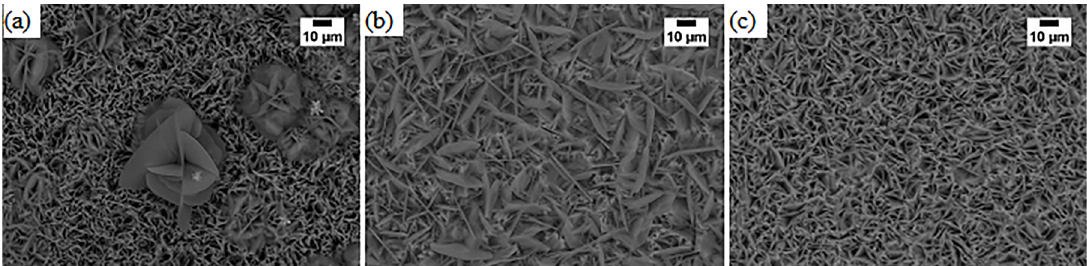
Figure 4. SEM images of aluminum alloy 5052 treated with stearic acid after HCl (2M) etching at different times: (a) 10 min; (b) 20 min and (c) 30 min .